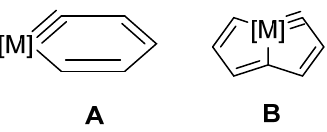
Figure 2. Strained metallacycles with carbyne bond.